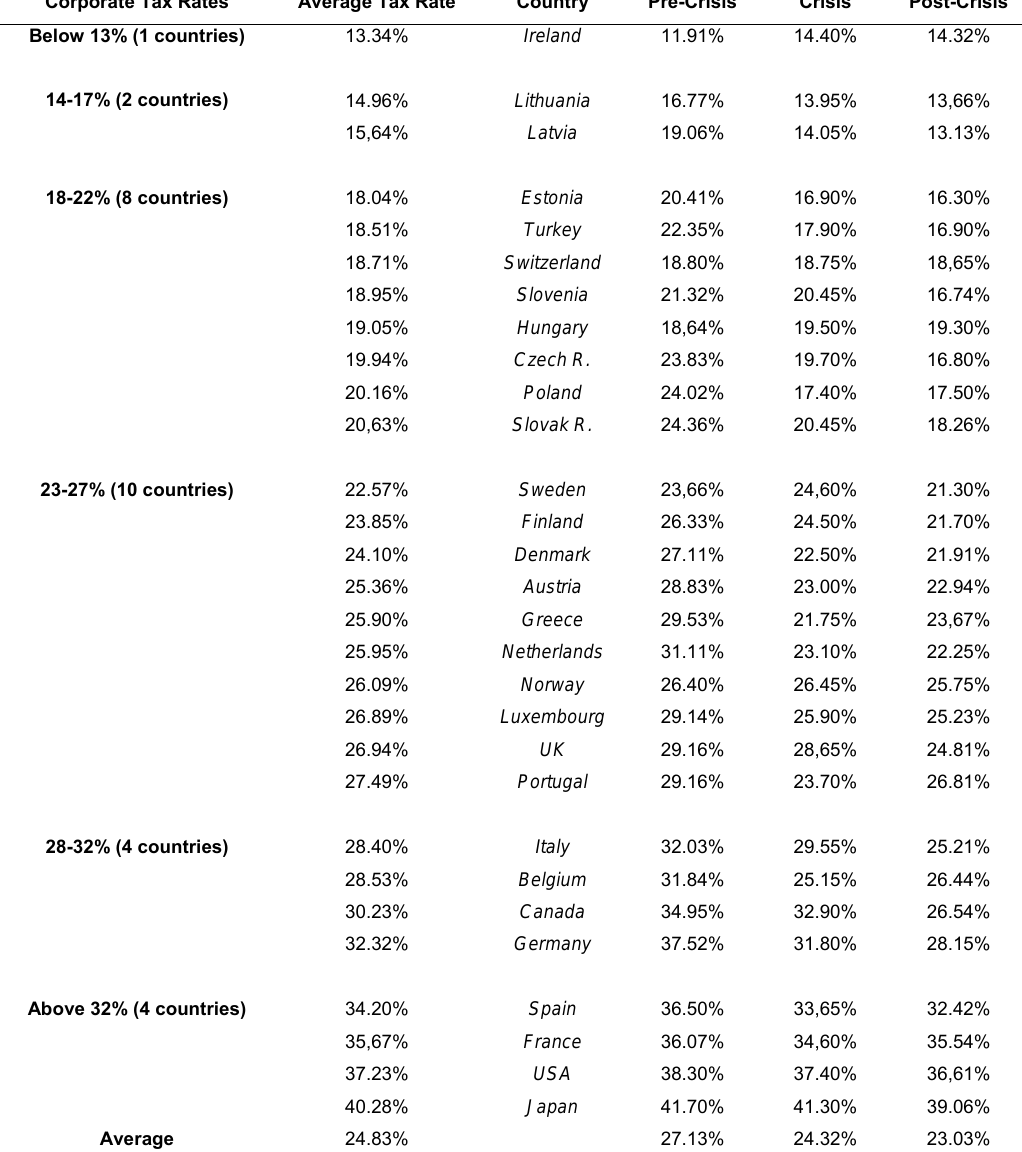
Table 2. Distribution of corporate tax rates in the countries over 1998-2005 Corporate Tax Rates Average Tax Rate